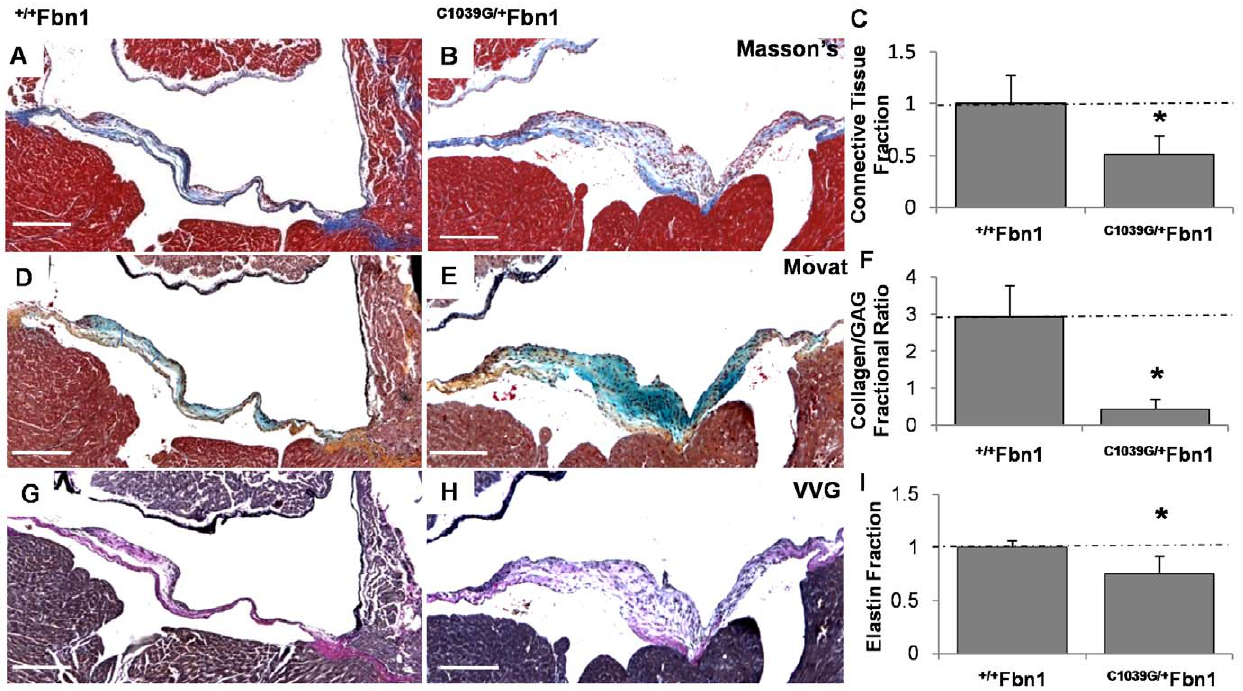
Figure 6. Differences between + / + Fbn1 and C1039G/ + Fbn1 mitral valve matrix composition at 4 months. (A–B) Masson’s Trichrome reveals a reduction in the fractional amount of connective tissue in the marfan mitral valve compared to wildtype. (C) Digital quantification of the connective tissue composition using color thresholding, with blue regions denoting connective tissue. (D–F) Movat’s stain reveals over 3-fold reduction in the fractional amount of collagen compared to GAGs in the Marfan mitral valve relative to the wildtype (yellow-collagen, blue-GAGs). (G–I) Verhoeff’s–van Gieson (VVG) stain reveals a significant reduction in the fractional amount of elastin in the Marfan mitral valve compared to the wildtype (purple/ black-elastin). Magnification, 6 4. Scale bars: 200 m m. Error bars show 6 SD, n $ 3 valves per condition. Asterisks denote statistical differences according to a Student’s t-test (p # 0.05).